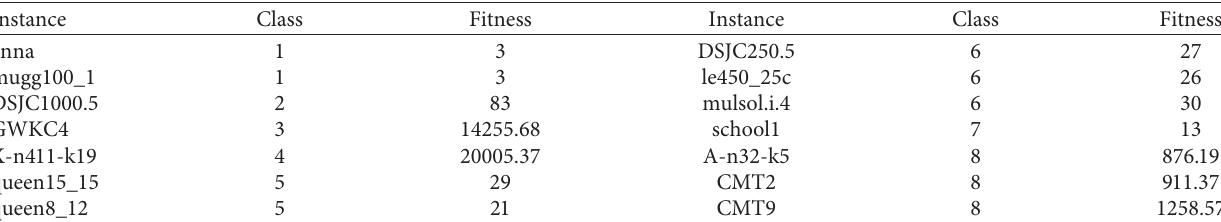
Table 18: Fitness results of test instances